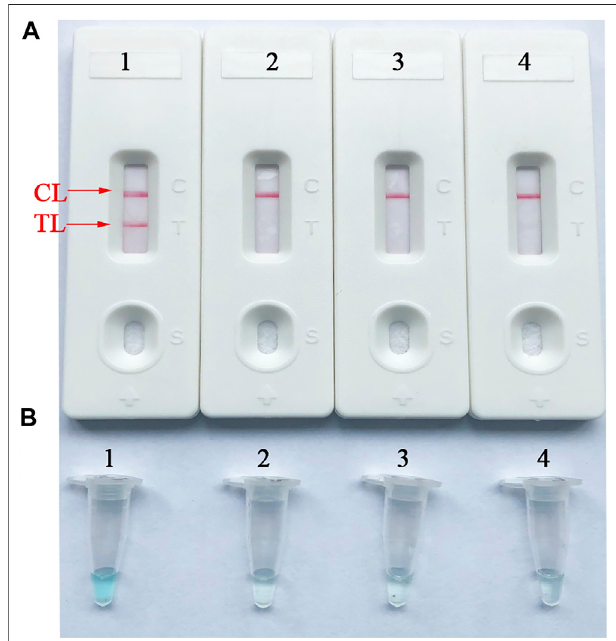
FIGURE 3 | Veri fi cation and analysis of B. abortus -LAMP-LFIA amplicons. (A) The LFIA strips used for rapid detection of B. abortus -LAMP- LFIA products. (B) Color change for B. abortus -LAMP-LFIA tubes. Strip/tube 1:positivereaction of B.abortus- LAMPproductsforthe B.abortus 544; strip/tube 2: negative control ( Listeria monocytogenes ); strip/tube 3: negative control ( Mycobacterium tuberculosis ); strip/tube 4: blank control (ddH 2 O). LAMP, loop-mediated isothermal ampli fi cation; LFIA, lateral fl ow immunoassay biosensor; TL, test line; CL, control line; ddH 2 O, double distilled